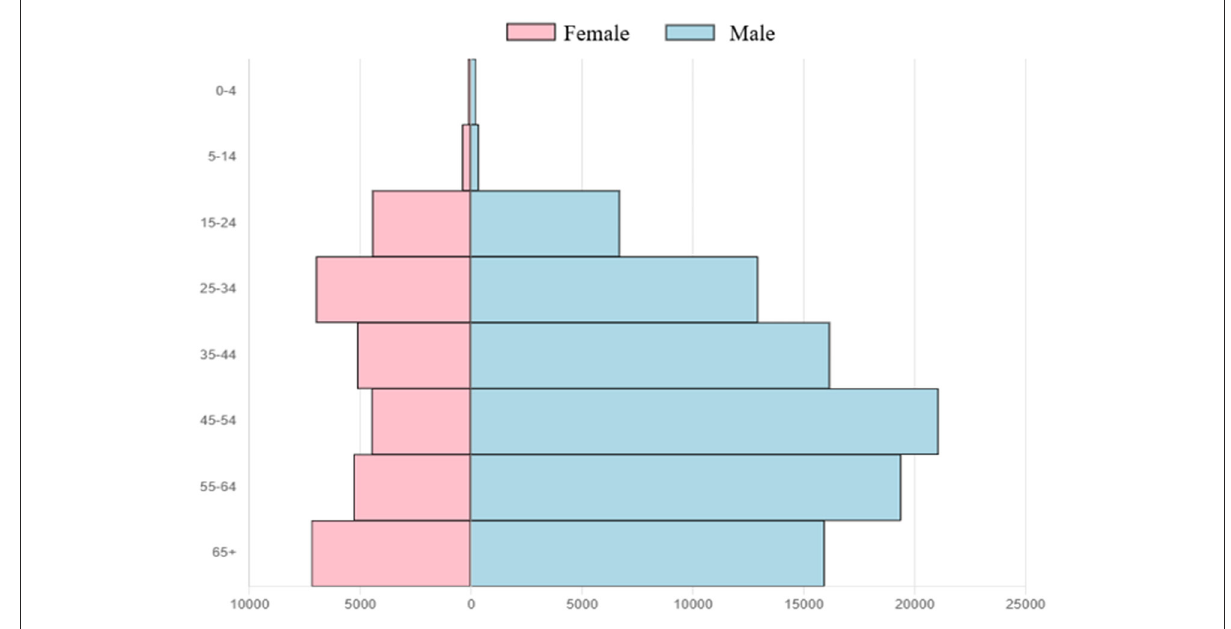
FIGURE2 Distribution of TB notifications by sex and age group in Vietnam in 2020.